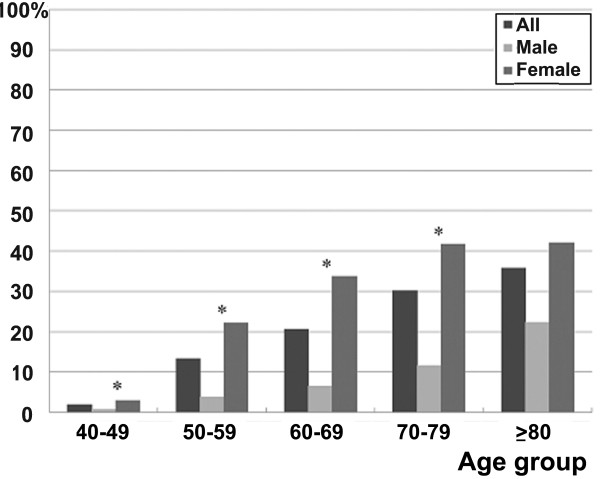
Prevalence of knee OA according to age groups. *P value < .050 by Chi square test or Fisher’s exact test between male and female subjects. OA = osteoarthritis.